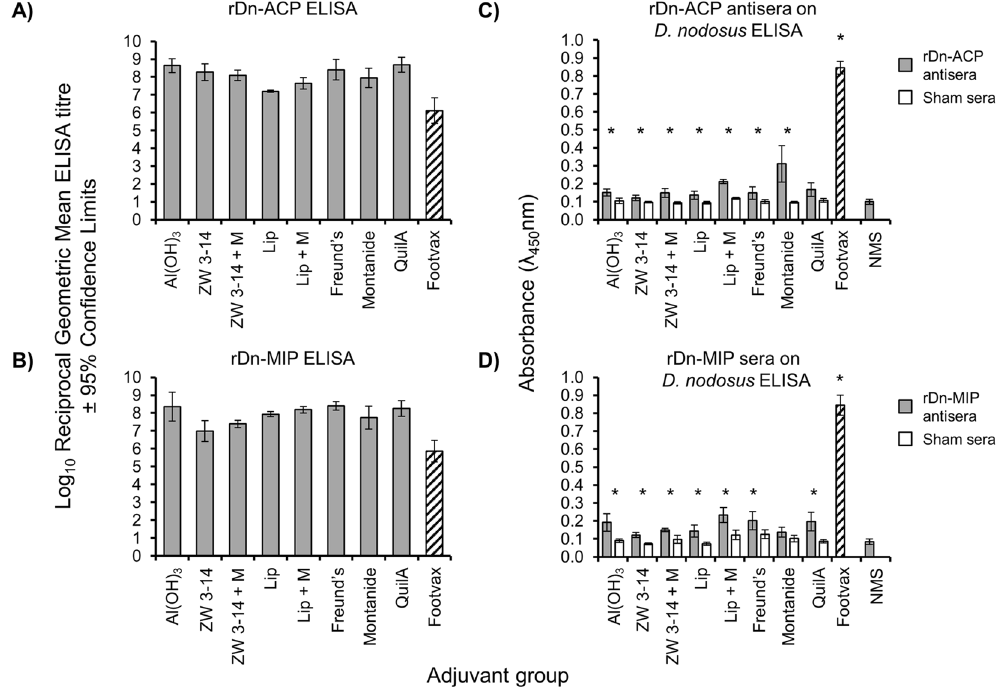
Figure 3. Enzyme-Linked ImmunoSorbent Assay (ELISA) on purified rDn-ACP and rDn-MIP proteins and on D. nodosus whole cells (whole-cell ELISA). ELISA reactivity of antisera from individual animals immunised with rDn-ACP or rDn-MIP delivered in Al(OH) 3 , Zwittergent (Zw) 3–14 detergent with or without Monophosphoryl Lipid A (MPLA), liposomes with or without MPLA, Freund’s adjuvant, MONTANIDE and saponin-based vaccine adjuvant Quil-A were reacted against their corresponding immunizing antigens: ( A ) purified rDn-ACP or B) purified rDn-MIP protein. Murine antisera to Footvax was also reacted against both recombinant antigens ( A,B ). The columns represent the geometric mean reciprocal ELISA titres (n = 5 animals per group) and the error bars represent the 95% confidence limits. No significant reactivity was observed with sera from sham-immunised animals or with NMS (absorbance values OD λ 450nm < 0.1 for serum dilutions of 1/10; data not shown). All same antisera to ( C ) rDn-ACP or ( D ) rDn-MIP protein were reacted in whole-cell ELISA against D . nodosus whole cells (1 µ g cells/well). The columns represent the average absorbance value (OD λ 450nm ) (n = 5 animals per group) and the error bars represent the standard deviation (SD). Significant reactivity in comparison to the corresponding sham sera or NMS is marked with an asterisk ( * ) (P <